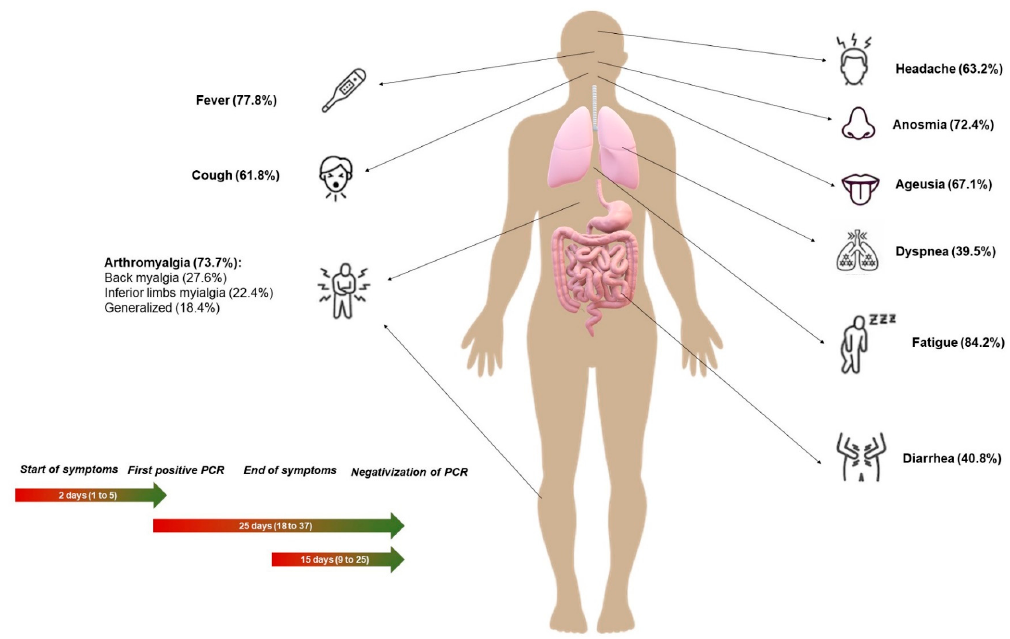
Figure 1. Most frequent symptoms and most relevant temporal outcomes in healthcare professionals with COVID-19.